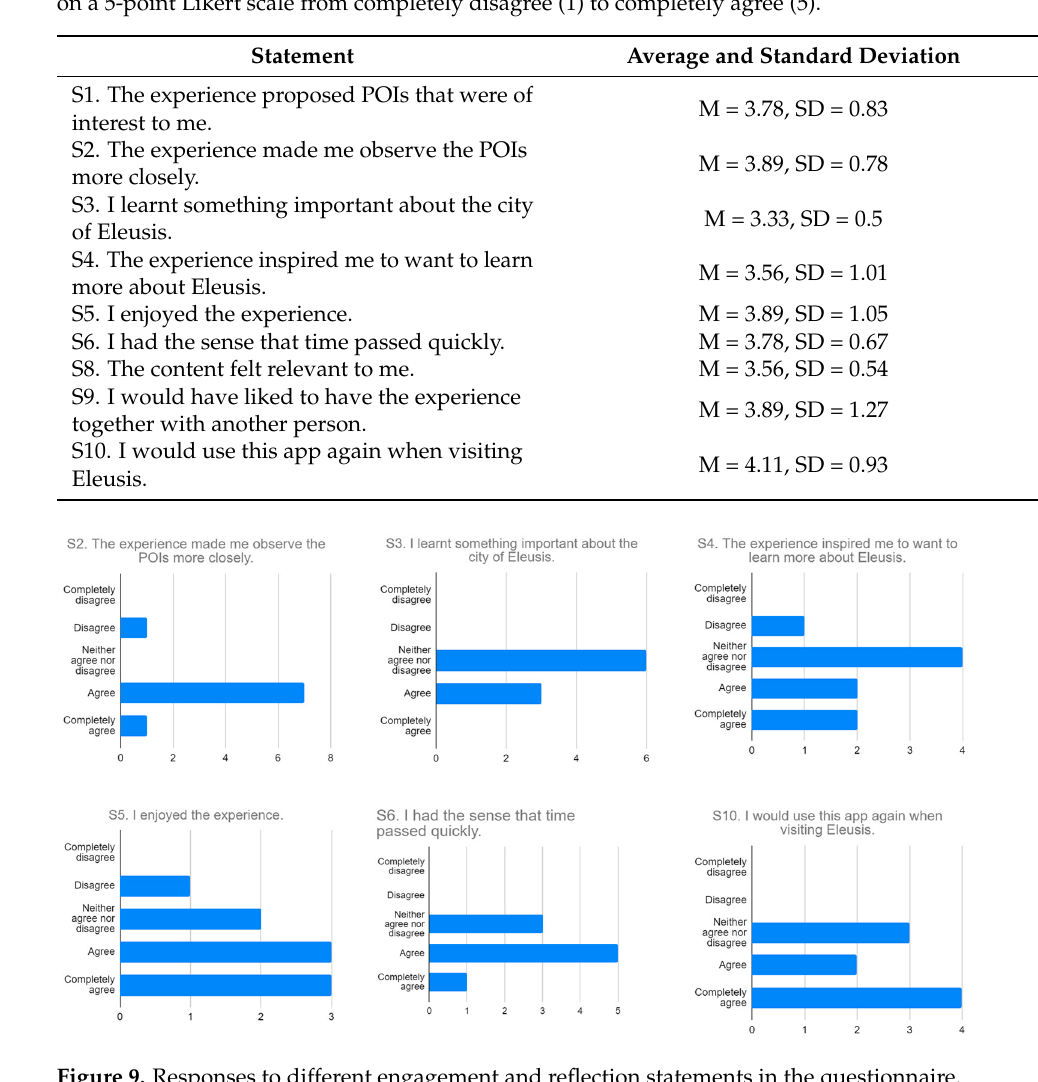
Figure 9. Responses to different engagement and reflection statements in the questionnaire.